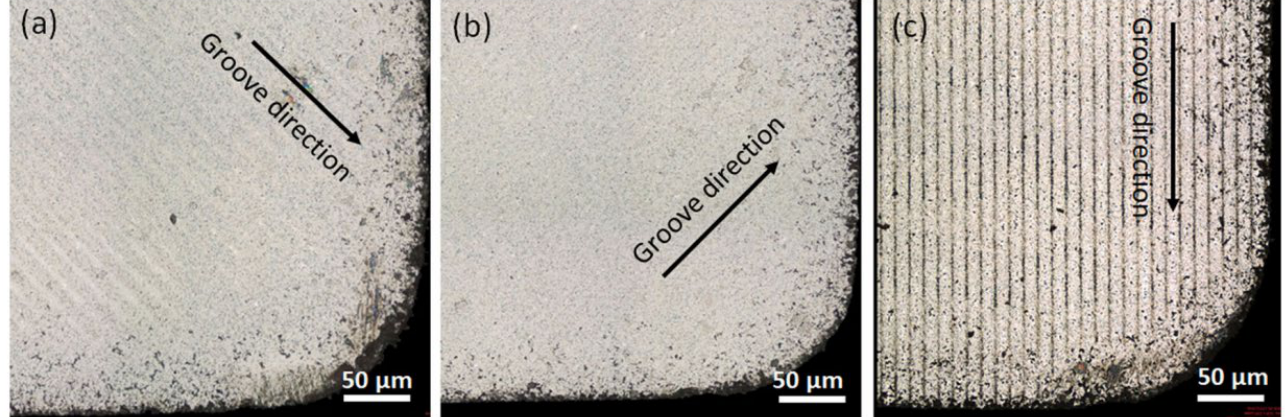
Figure 14. Optical microscopy of micro-nano laser processed samples: ( a ) of grooves parallel to CFD; ( b ) grooves perpendicular to CFD; and ( c ) grooves parallel to MCE [80].